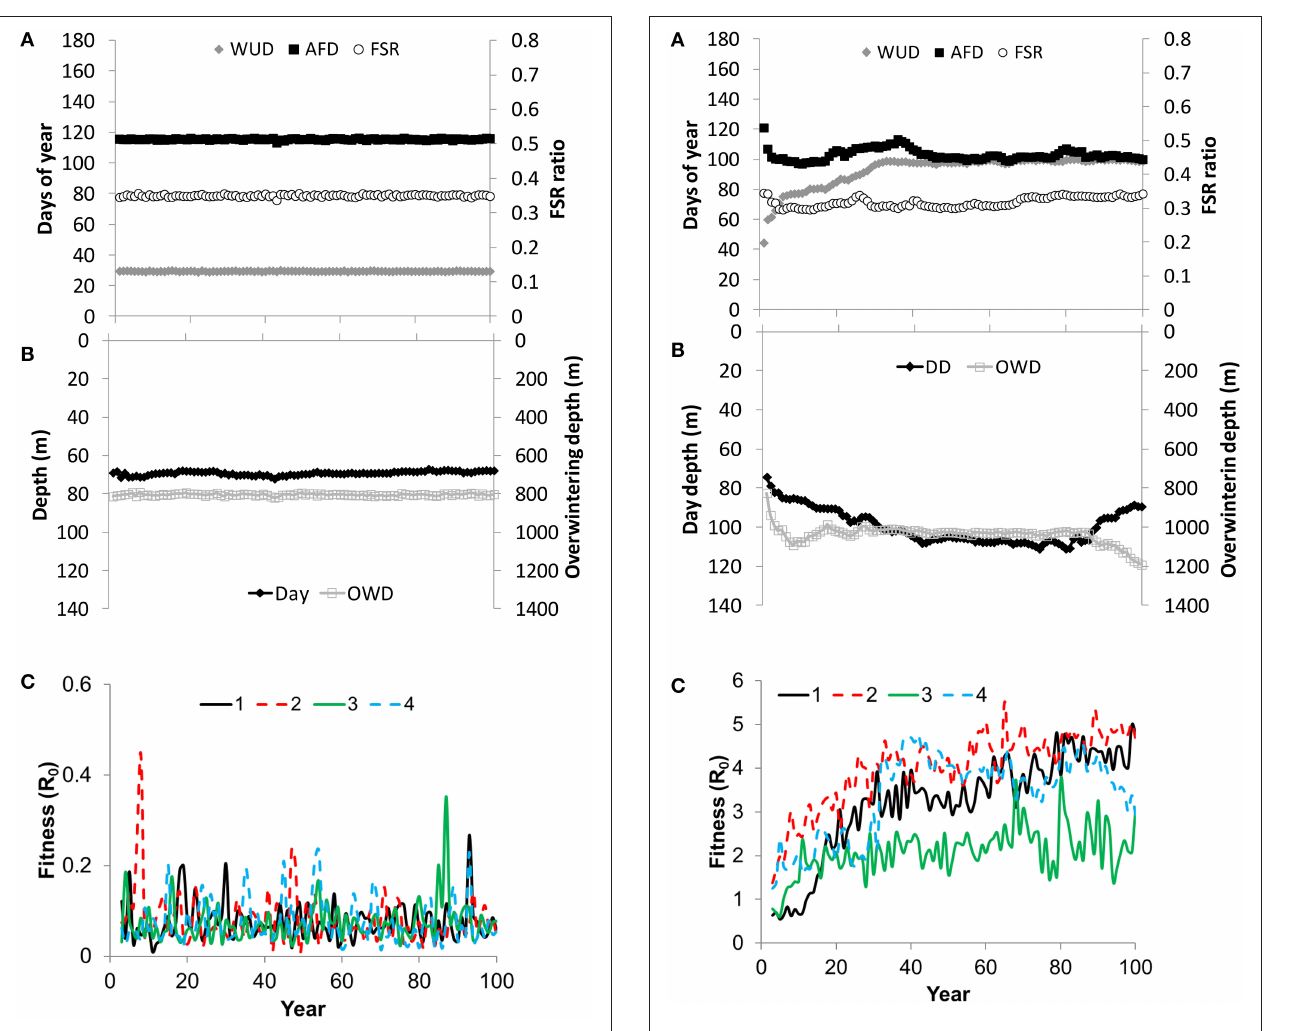
FIGURE 5 | The development over 100 years of the best replicate in simulation 3 in (A) wake up day (WUD), allocation to fat day (AFD) and fat to soma ratio (FSR) traits, (B) the day depth (DD) and overwintering depth (OWD), and (C) fitness (the net reproductive rate, R0) of all four replicates. Values are from end of each year.